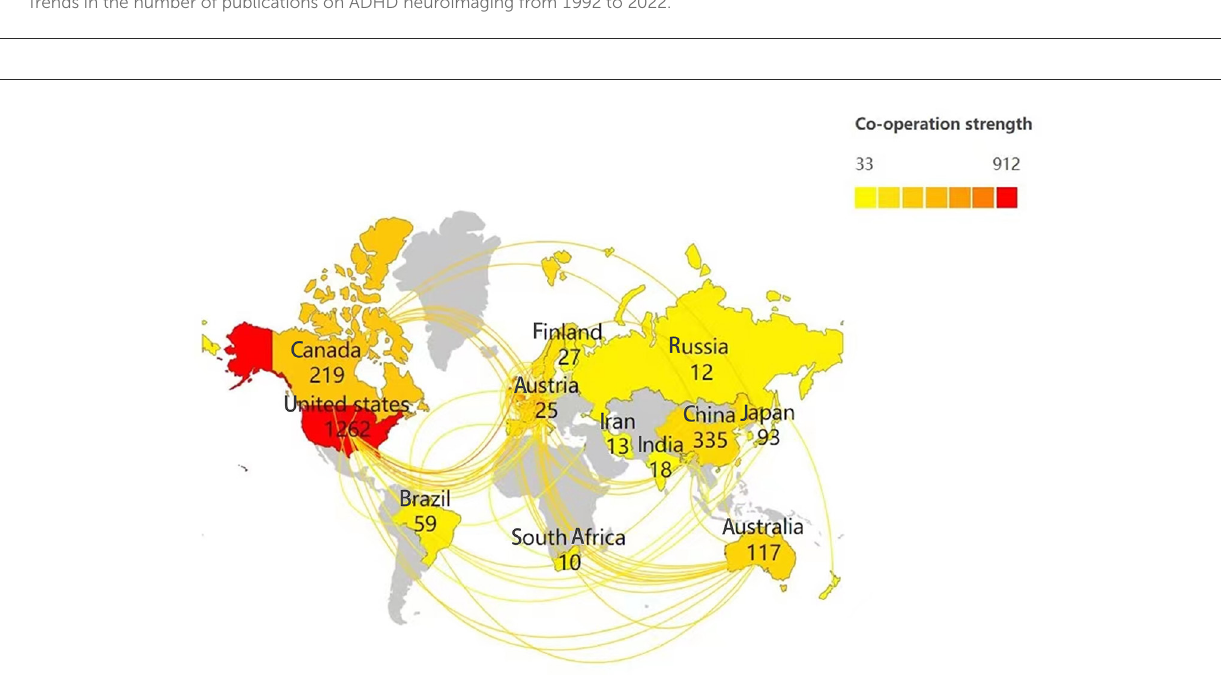
FIGURE3 Collaboration network of countries researching ADHD neuroimaging.